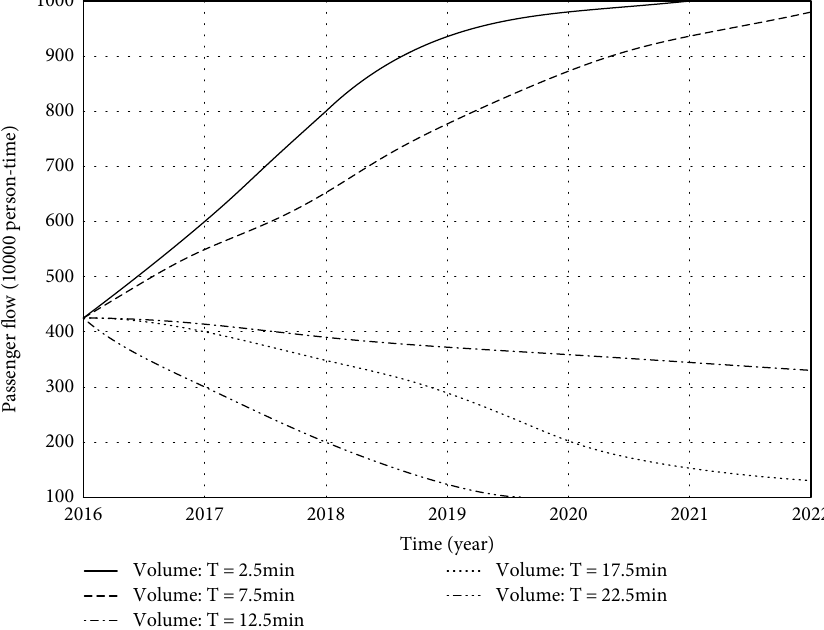
Figure 7: The impact of service level on passenger